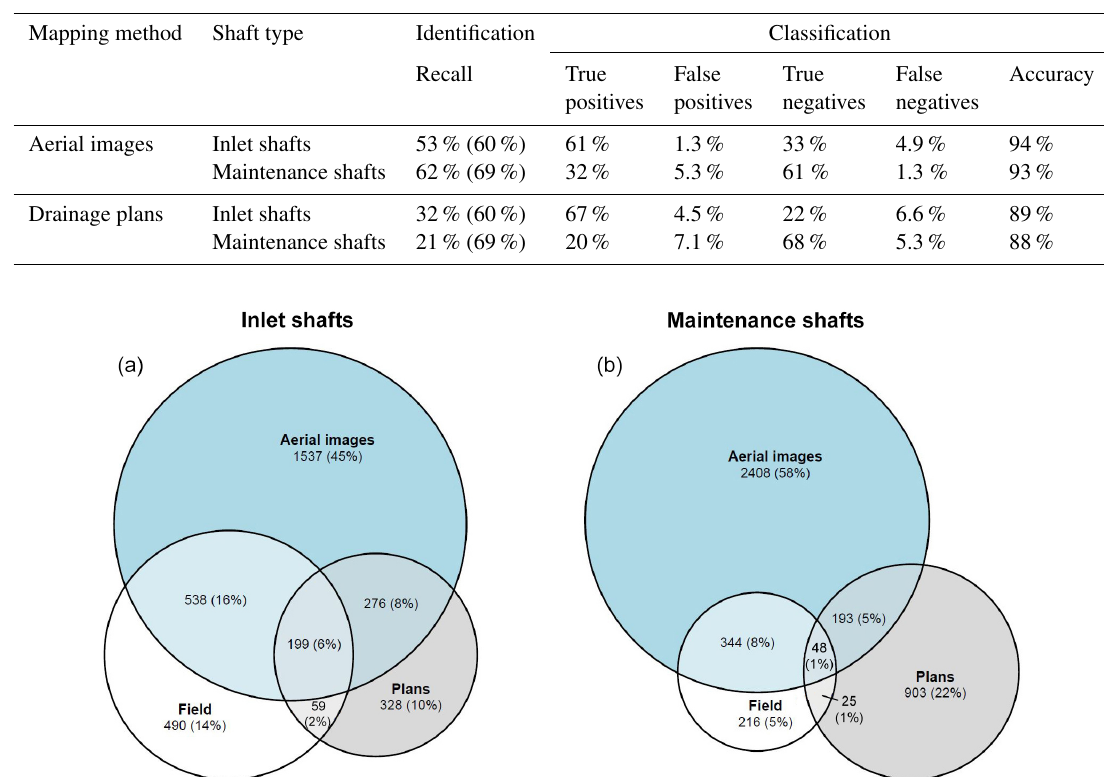
Figure 4. Number of inlet (a) and maintenance shafts (b) identified by the different mapping methods.